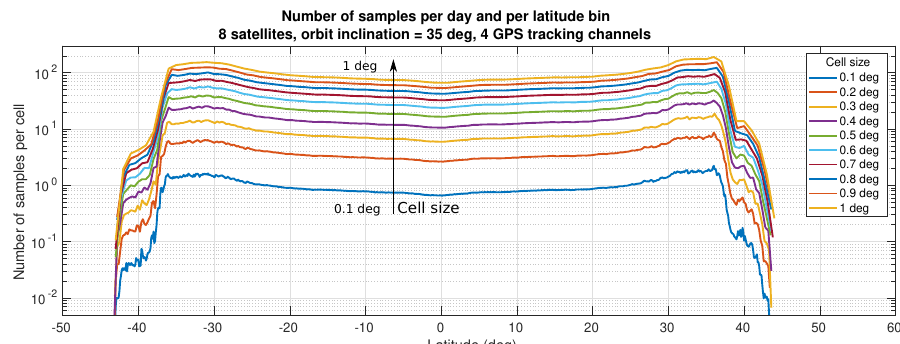
Figure 1. Average number of samples per day and per cell, for different cell sizes (from 0.1 ◦ × 0.1 ◦ to 1 ◦ × 1 ◦ ) for the 8 Cyclone Global Navigation Satellite System (CYGNSS) satellites tracking up to 4 GPS satellites simultaneously from 90 min period and 35 ◦ of inclination